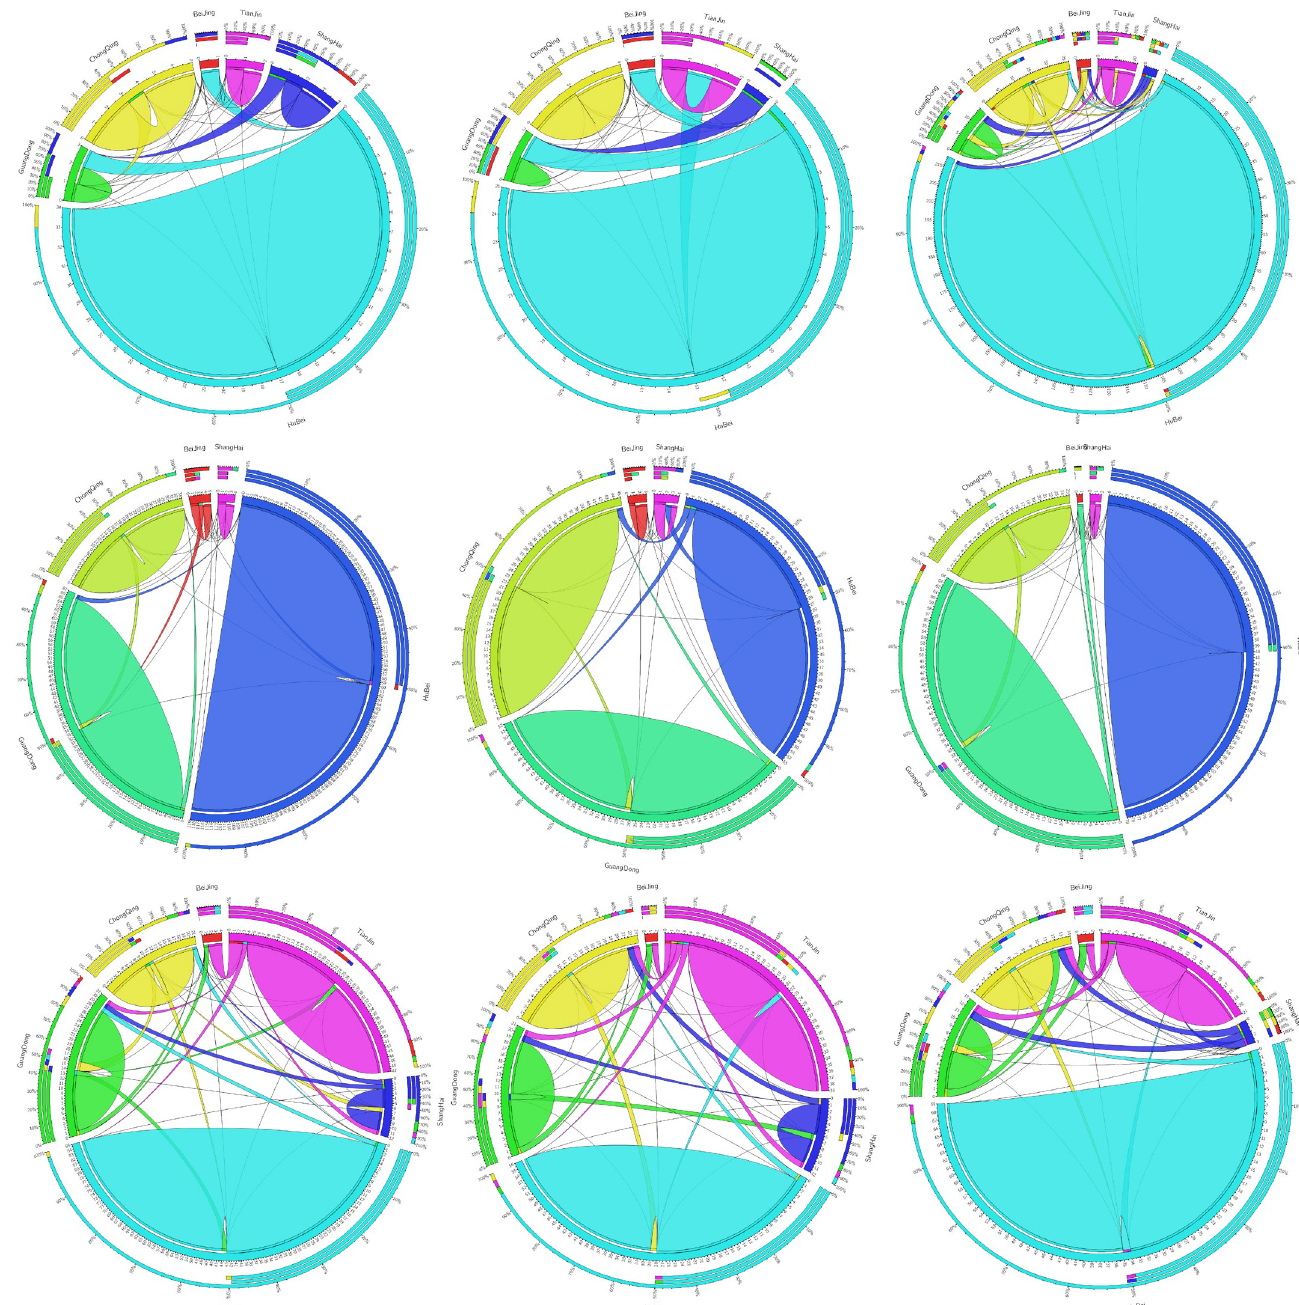
Figure 9. Carbon emissions flows among the pilot areas. The top three chords represent the carbon emissions flow chart between the pilot areas of the chemical industry in 2012, 2015, and 2017. The three chords in the middle represent the carbon emissions flow chart between the pilot areas of the building materials industry in 2012, 2015, and 2017. The bottom three chords show the carbon emissions flow chart between the pilot areas of the metal industry in 2012, 2015, and 2017.